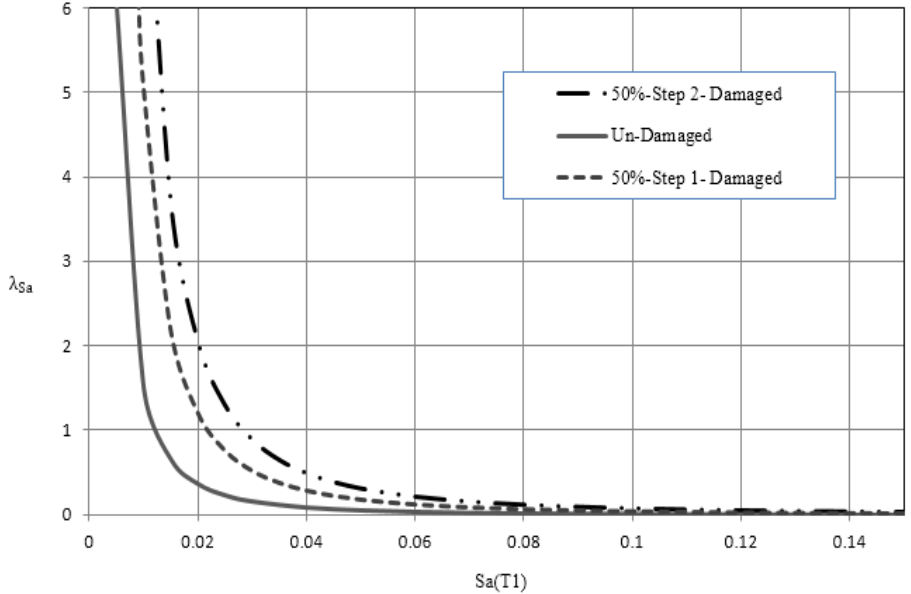
Figure 33. Comparison of uniform hazard curves for three frames.